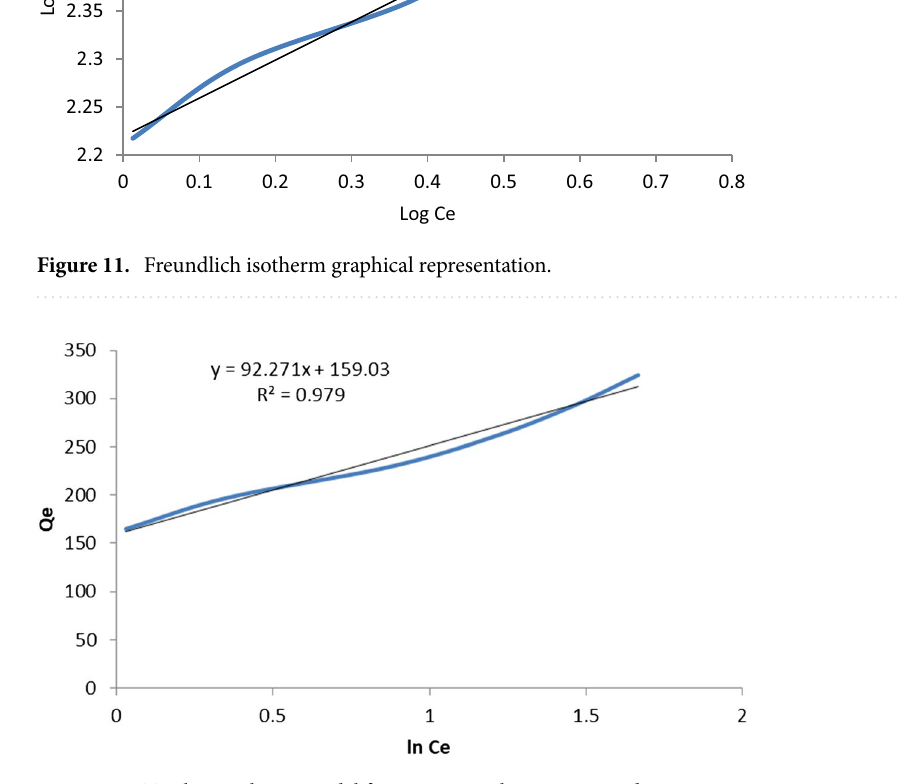
Figure 12. Temkin isotherm model for MB removal onto Rumex